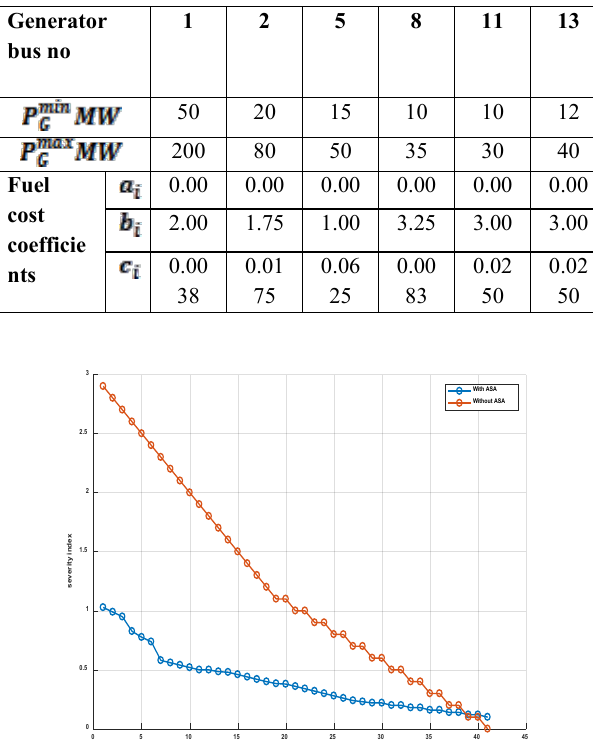
Figure 2. Basic structure of the IEEE 30 bus system Tabl e 2. IEEE 30 bus system generator and cost